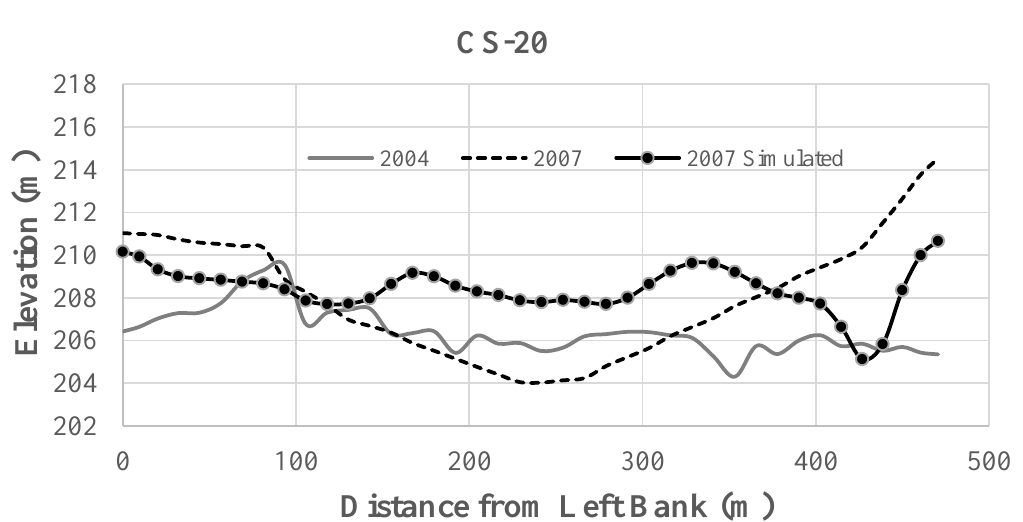
Figure 16. Comparisons of cross section profiles.